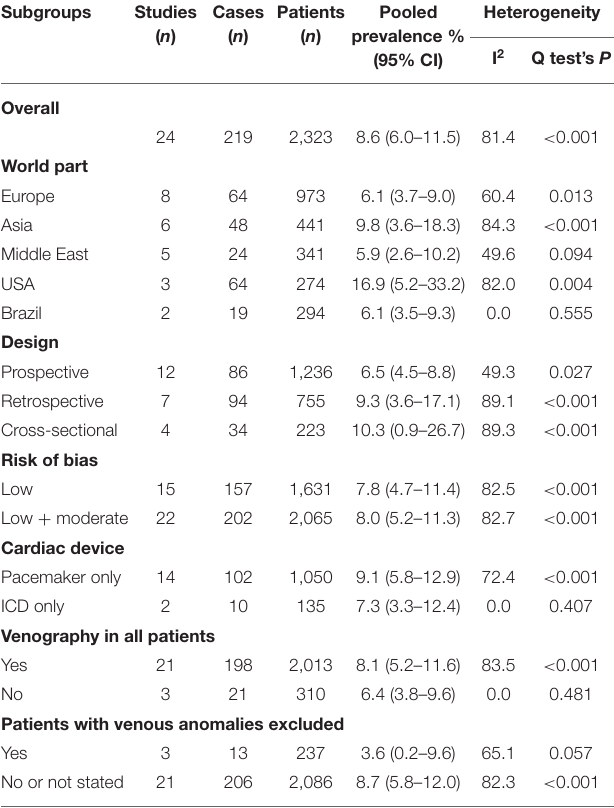
TABLE 2 | Subgroup analysis for the prevalence of asymptomatic vein occlusion.